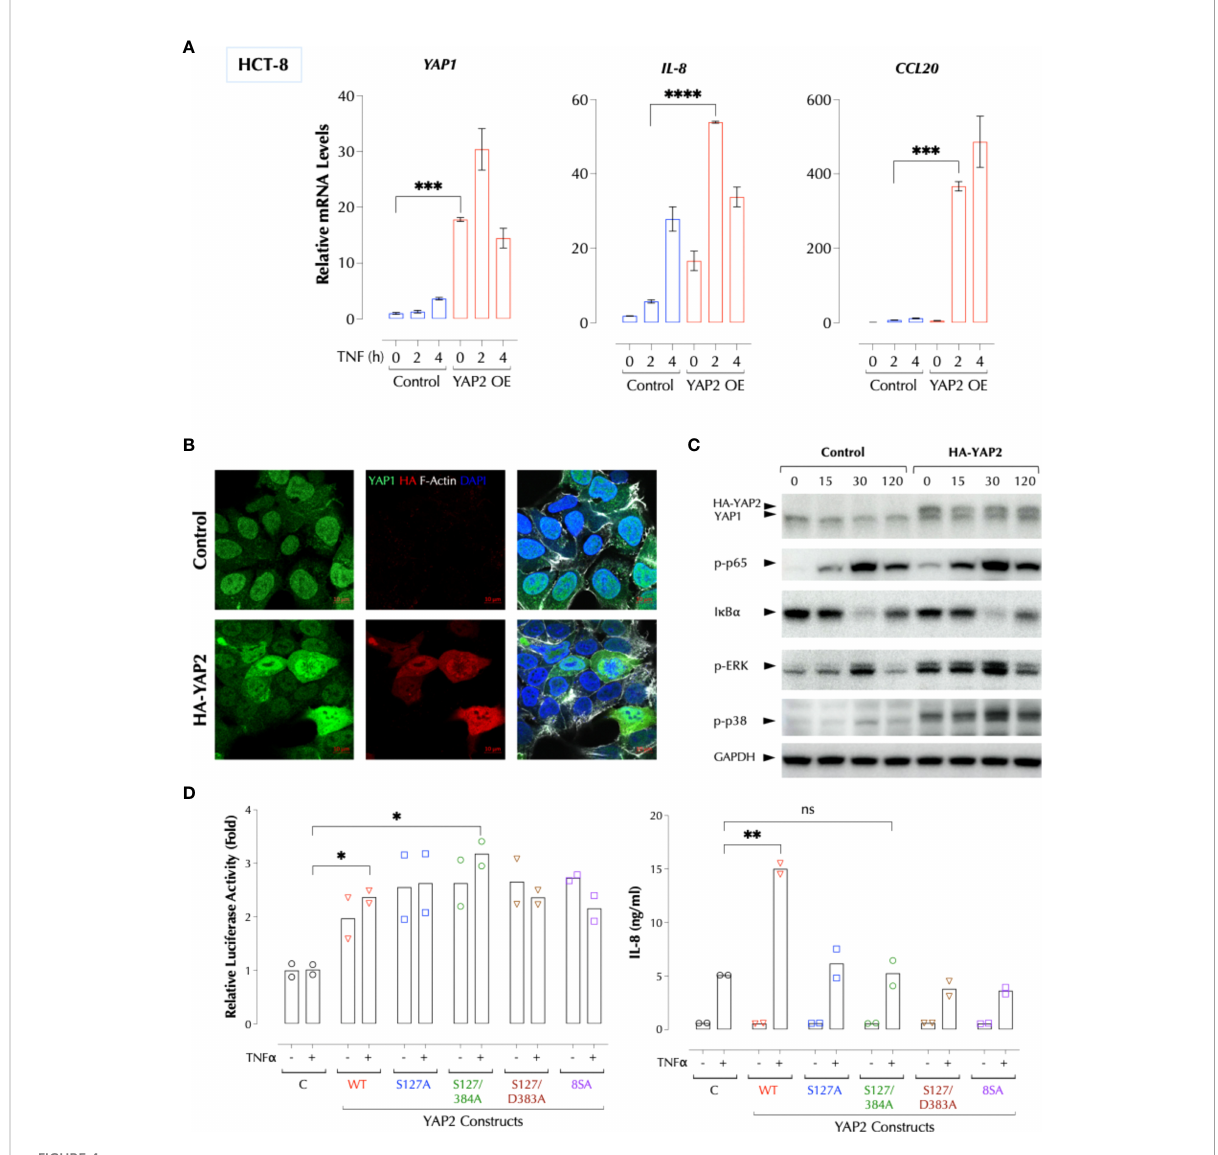
FIGURE 4 YAP2 enhances the in fl ammatory responses via a non-transcriptional activity. (A) YAP2 enhances the TNF response. The C or YAP2-OE HCT-8 cells were stimulated with TNF a (2ng/ml) for 2-4h and the mRNA levels of the indicated genes were measured by qPCR. (B) YAP2 is localized mostly in the nucleus in 2D HCT-8 cells similarly to the endogenous YAP1. (C) YAP2 enhances the TNF signal transduction. Control DNA or HA- YAP2 transfected HCT-8 cells were stimulated with TNF a (2ng/ml) for the indicated time periods and activation of NF- k B and MAP kinases was measured by western blotting. (D) Non-transcription activity of YAP2 enhances the TNF response. The indicated YAP2 constructs were transfected with a YAP reporter and the YAP1-mediated transcriptional activity was measured with Dual-Luciferase ® Reporter Assay System and IL-8 by ELISA. * P < 0.05, ** P < 0.01, *** P < 0.001, ****: 0.0001, ns, not signi fi